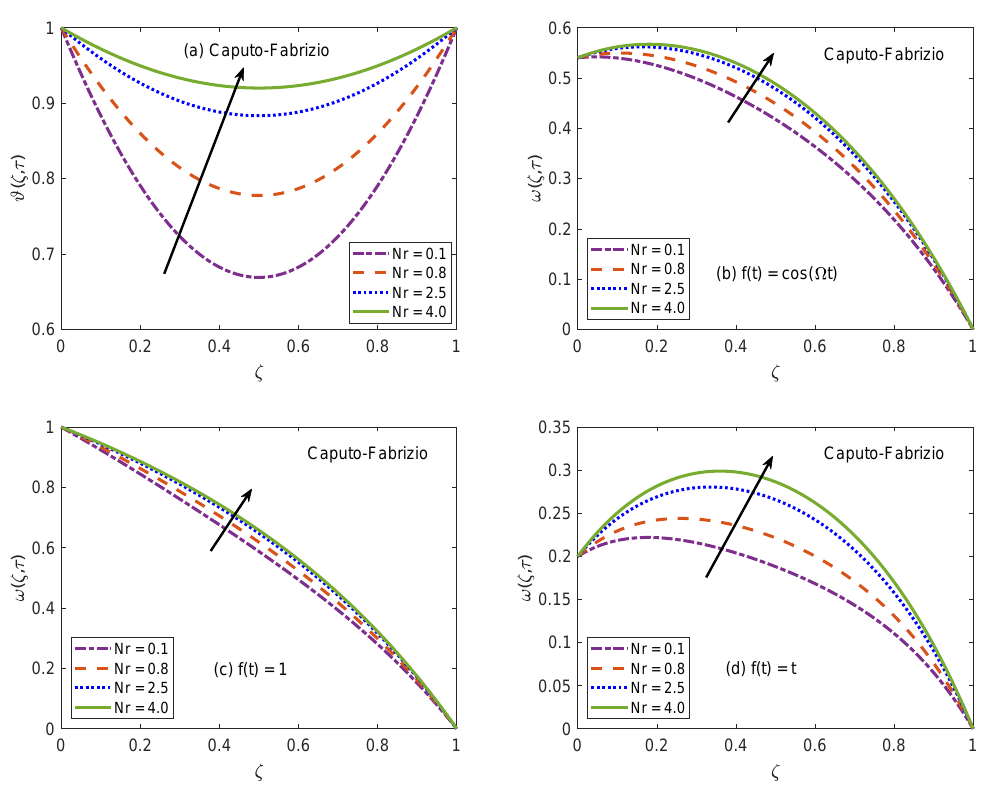
Figure 9. Temperature and velocity patterns of CF model for variation of Nr